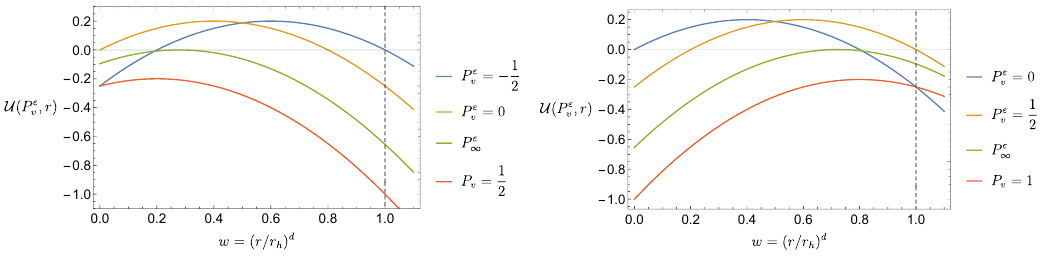
Figure 3 . The effective potentials U ( P ε , r ) for the future boundary Σ + (left) and the past boundary v Σ (right), respectively. Hence ε = + ( − ) in the left (right) panel. For this figure, we have chosen − d = 2 and α ± = 1 = α B